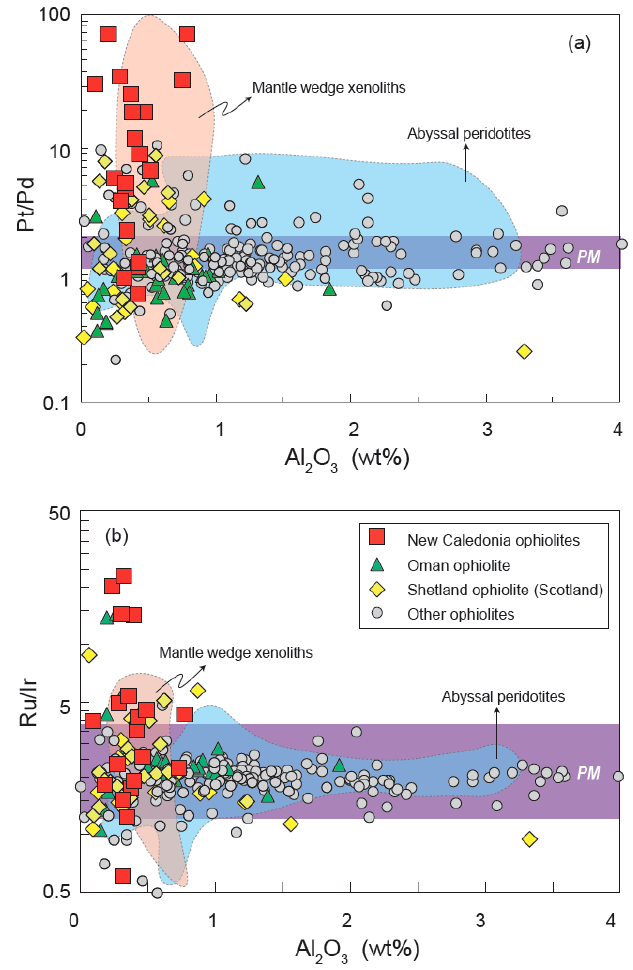
Figure 9. Plots of Pt/Pd ( a ) and Ru/Ir ( b ) versus Al 2 O 3 contents. Data of the Oman ophiolites are from [ 58 ] , the Shetland ophiolites from [ 60 , 61 ] , other peridotites are from [ 53 , 62–70 ] . Fields of mantle wedge xenoliths [ 12 , 13 ] and abyssal peridotites are shown for comparison [ 32 , 37 , 43–45 ]